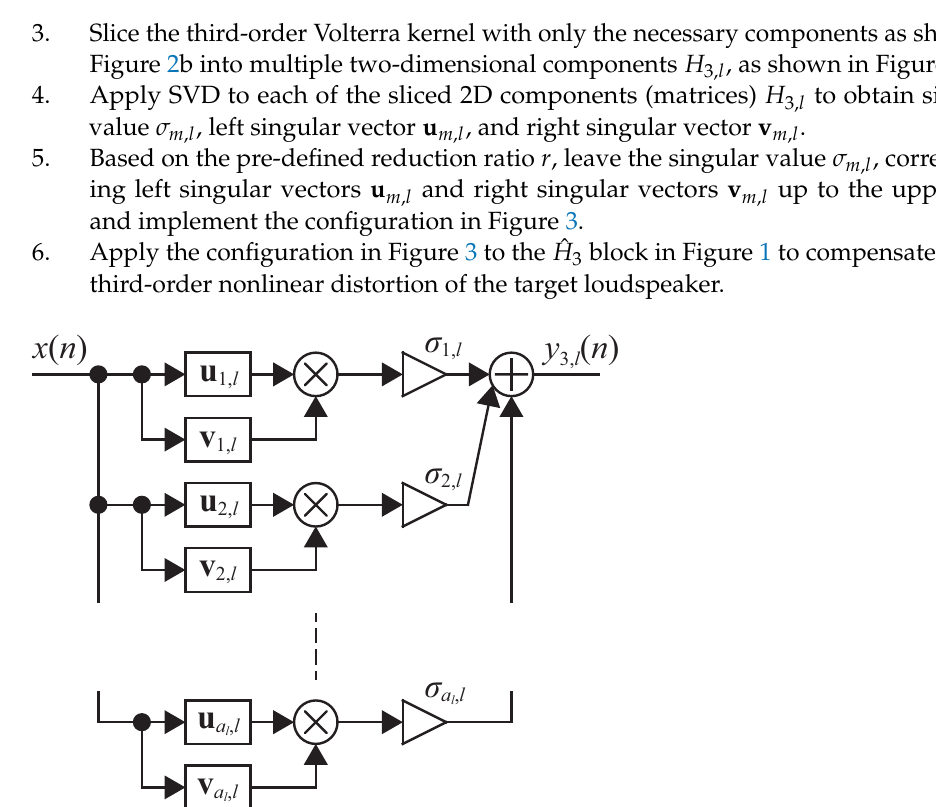
Figure 3. Block diagram of l th layer of the proposed structure based on singular value decomposition.